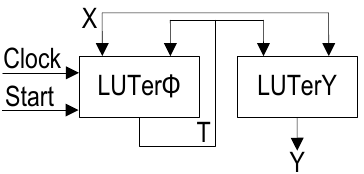
Figure 2. Structural diagram of LUT-based FSM U 1 .